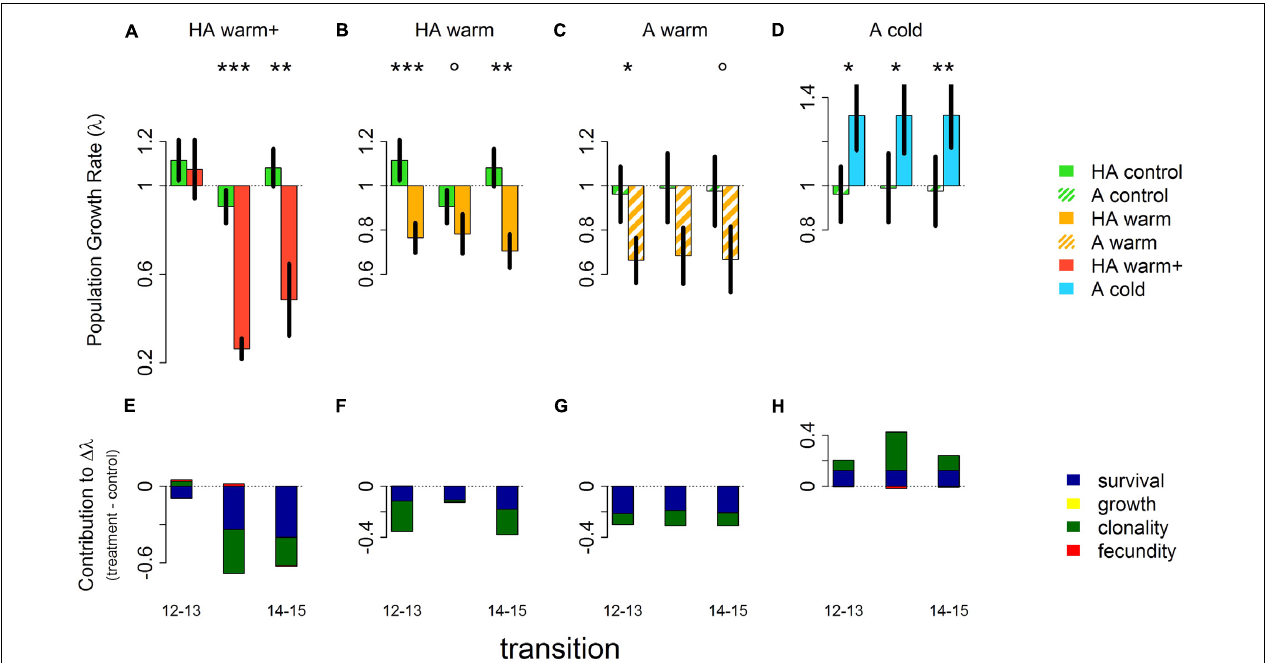
FIGURE 2 | Population growth rates ( λ ) for each transition (i.e., annual transitions: 2012–2013, 2013–2014, and 2014–2015) in controls at the site of origin and transplants at the target sites (A–D) and contributions to differences in population growth rates between transplants and the respective controls at the site of origin (E–H) . Treatment colors in panels (A–D) match the colors in Figure 1 . Error bars in panels (A–D) show ± 1 standard deviation of λ from the bootstrapped datasets ( n = 2200). Significant differences between λ in controls and transplants indicated by asterisks: ∗∗∗ p < 0.001, ∗∗ p < 0.01, ∗ p < 0.05, ◦ p < 0.1.